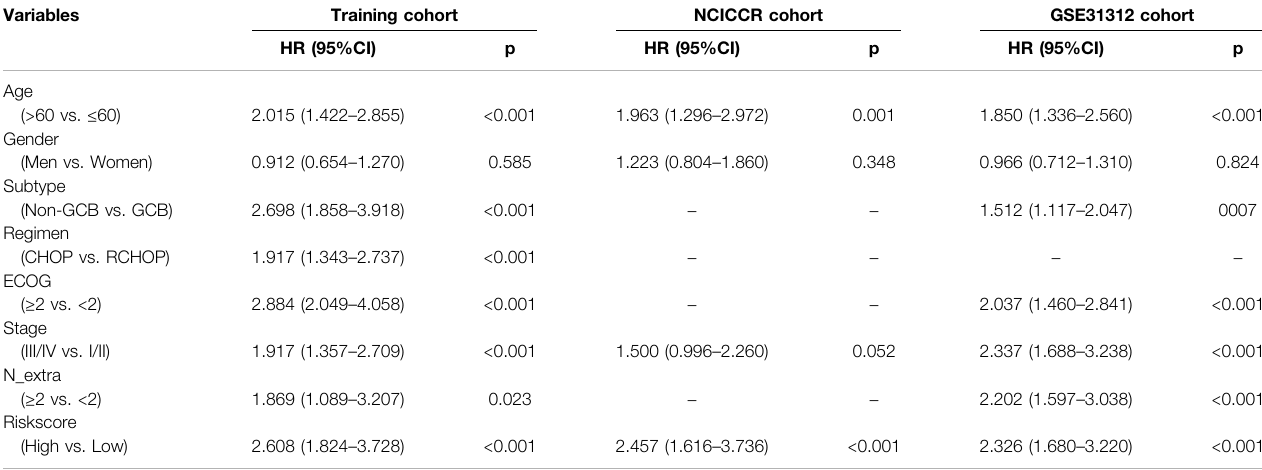
TABLE 2 | Univariate Cox regression analysis of overall survival in the training and validation cohorts.